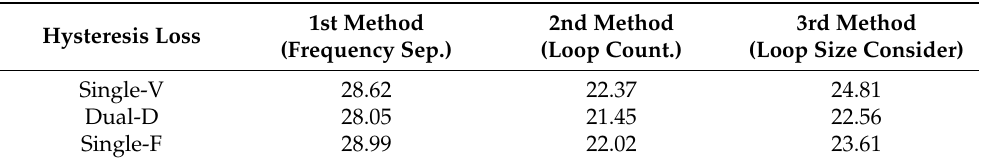
Figure 9. ( a ) Three different hysteresis loss calculation with 4 steps different operation points. ( b ) Two different eddy current loss calculation with 4 steps different operation points. Table 1. Comparison of iron losses of three different calculation methods at 6540 rpm, 24 A phase current.